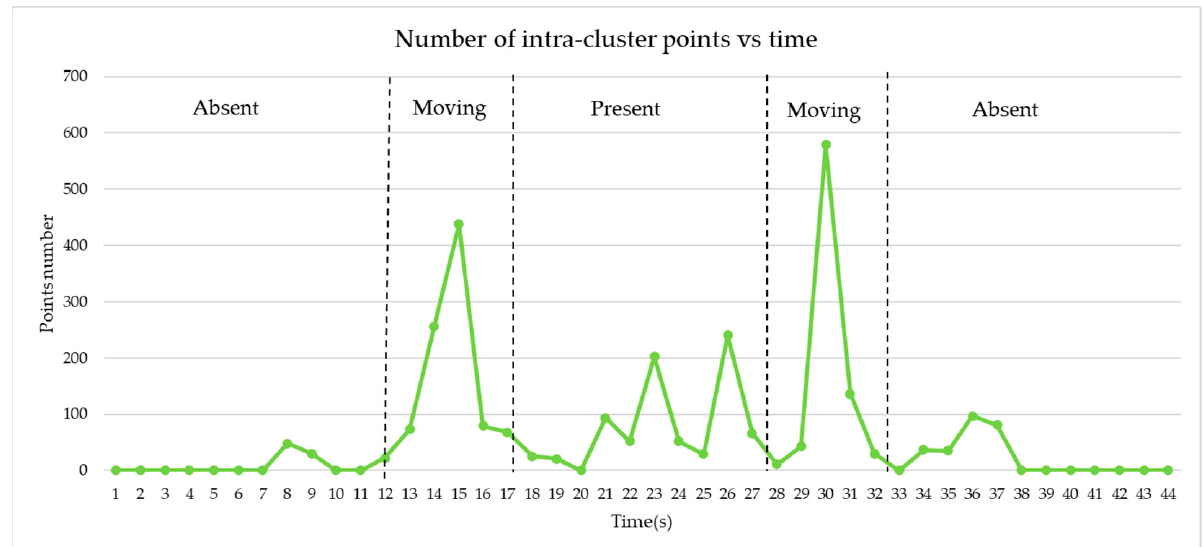
Figure 9. Case of a single person getting on and then getting off the car. The figure presents the number of points within the cluster corresponding to the occupied seat as a function of the test person’s actions.